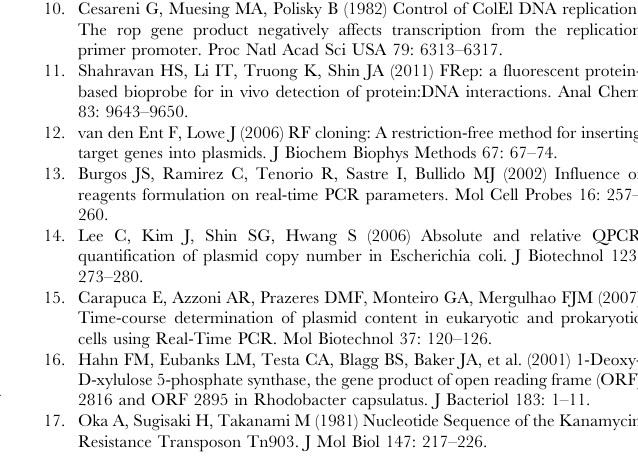
Figure S1 Full sequence of the p15A origin of replication ( ori) in pSAM. (TIF) Figure S2 Standard curve used to assess qPCR with and without whole cells. (TIF) Figure S3 Construction of pSAM. More experimental details regarding